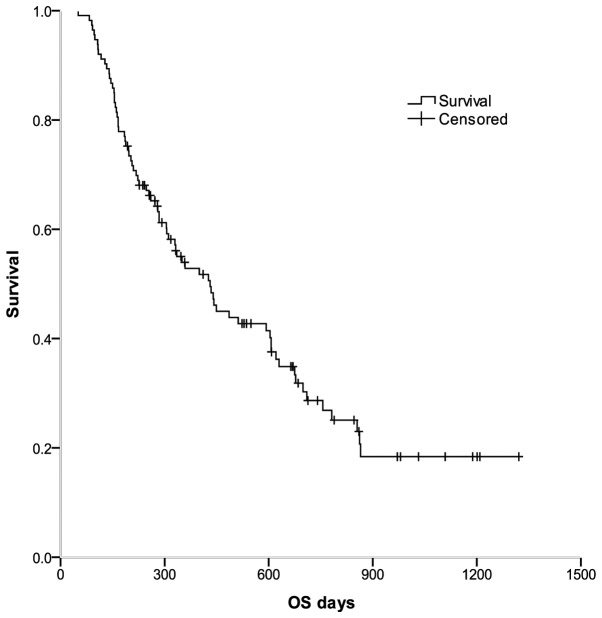
OS in the whole series. Kaplan-Meier curves were generated to show the OS of all HCC patients following TARE. OS, overall survival; HCC, hepatocellular carcinoma; TARE, transarterial radioembolization.